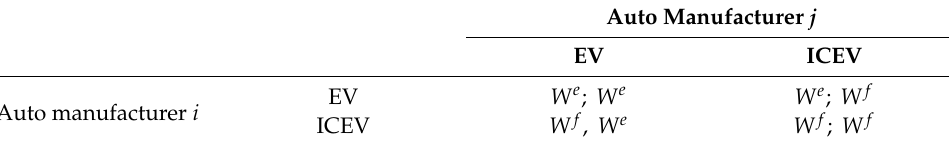
Table 1. The game matrix of